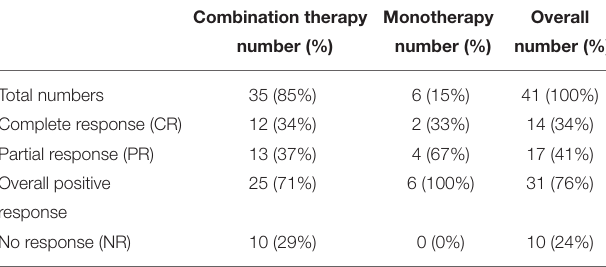
TABLE 1 | The response of Mirabegron treatment in